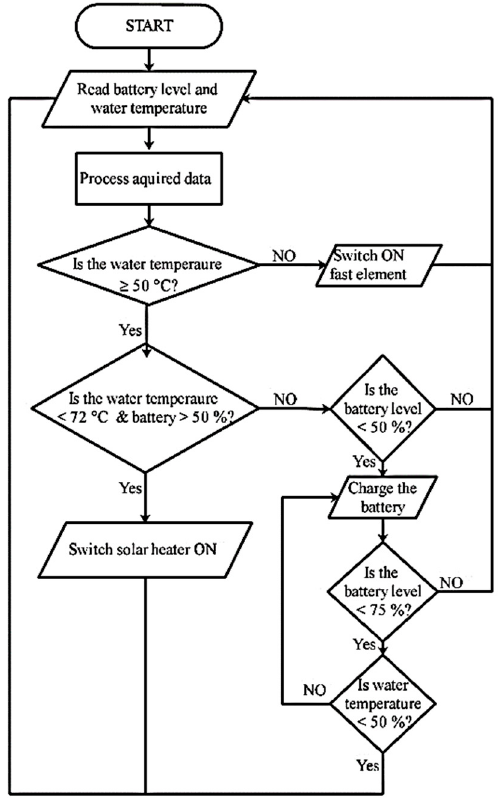
Figure 7. Geyser control software algorithm.